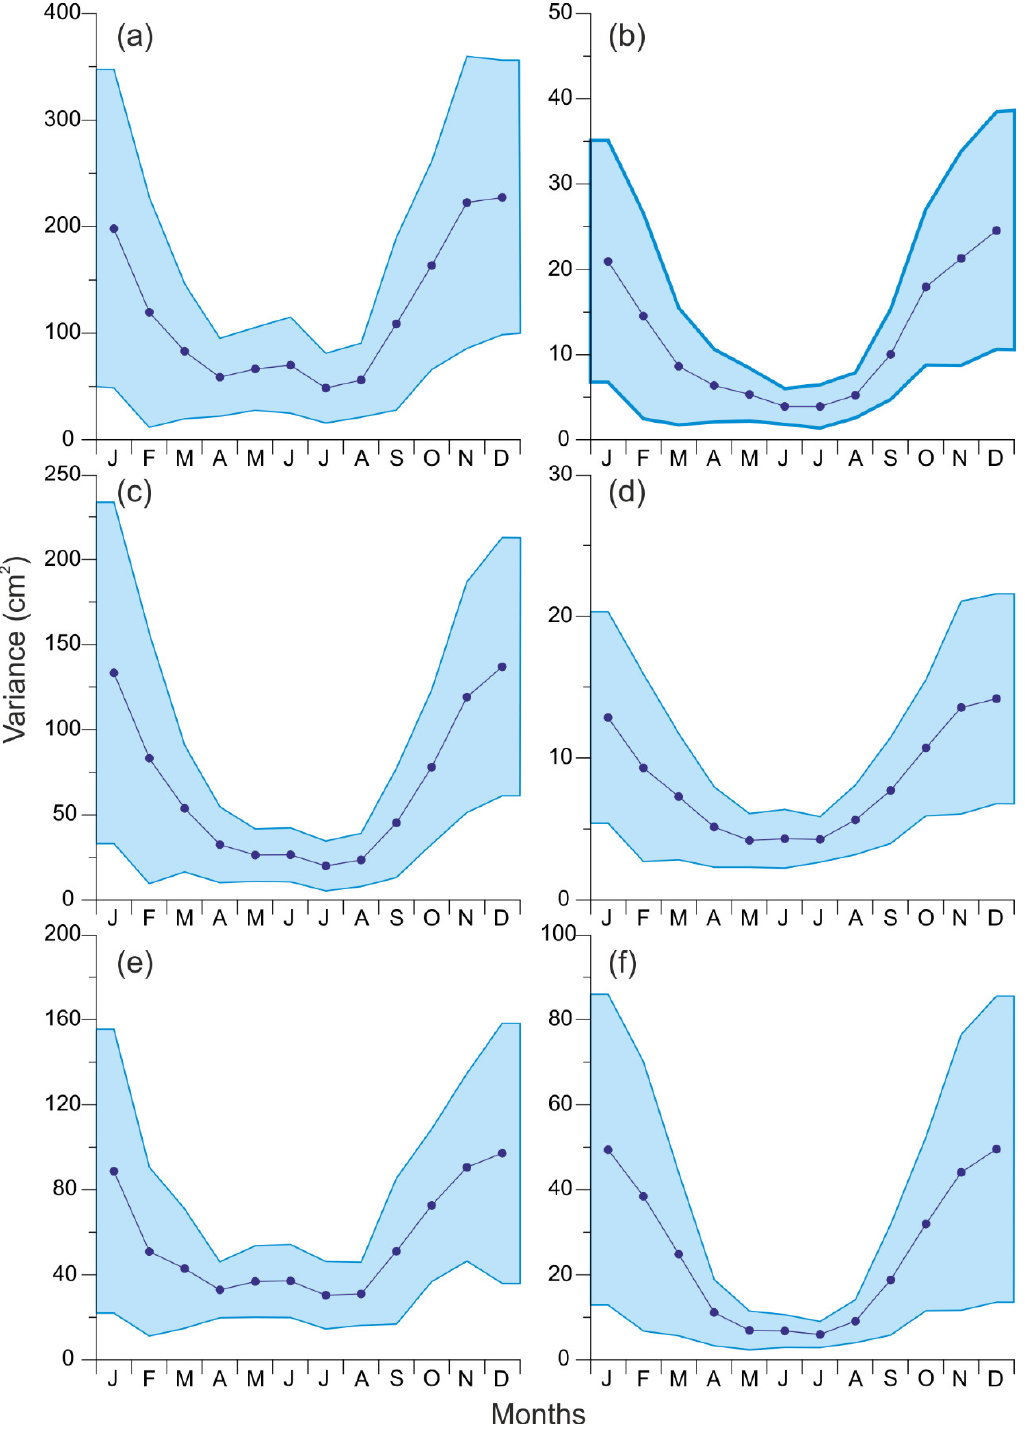
Figure 4. Seasonal changes of the variance of the mesoscale sea level oscillations ( σ 2 mes ) for stations at ( a ) the Gorny Institute, ( b ) Ratan, ( c ) Narva, ( d ) Stockholm, ( e ) Pärnu, and ( f ) Kungsholmsfort. The light blue color is ± standard deviations of interannual changes of σ 2 mes , blue vectors are trends of its value: up is positive, down is negative, right is no